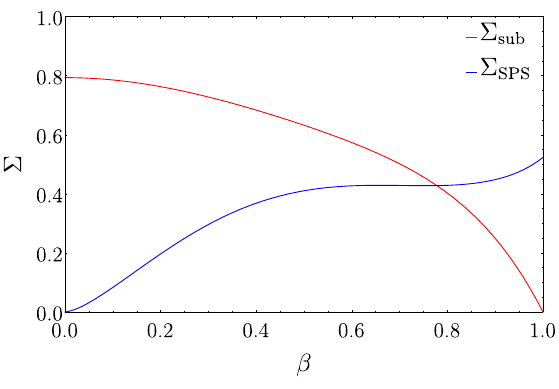
Figure 20 . The scaled cross section Σ defined in (9.23), plotted for the gg SPS (Σ SPS ), and the subtraction term (Σ 1v1,pt